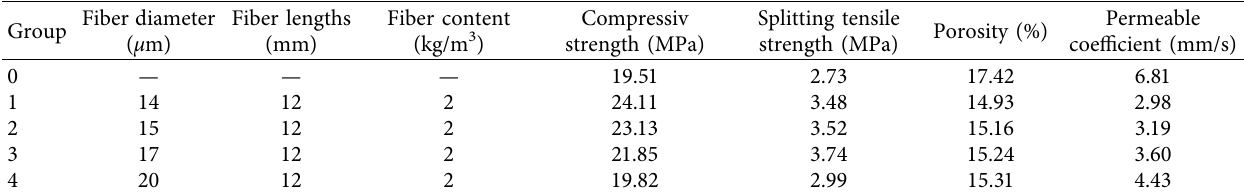
Figure 10: Experimental advice of fxed head method. (Note: 1-water supply system, 2-overfow pipe, 3-fow trough, 4-pervious concrete test block, 5-measuring cylinder, and 6-water level diference). Table 4: Test results of pervious concrete with diferent basalt fber